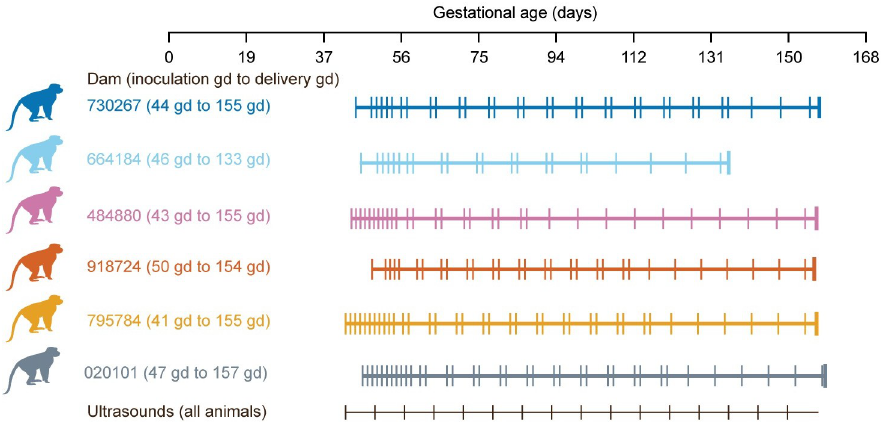
Fig 2. Pregnancy experimental design, maternal plasma vRNA loads and maternal antibody responses. Pregnant macaques were inoculated with ZIKV-PR (all colors) or PBS (grey color) in the first trimester. One female had a stillbirth at 133 gestational days (gd). Maternal blood was obtained at the times indicated for each animal (vertical lines on each animal’s timeline) and ultrasound analyses of the fetus and placenta were performed weekly (black vertical